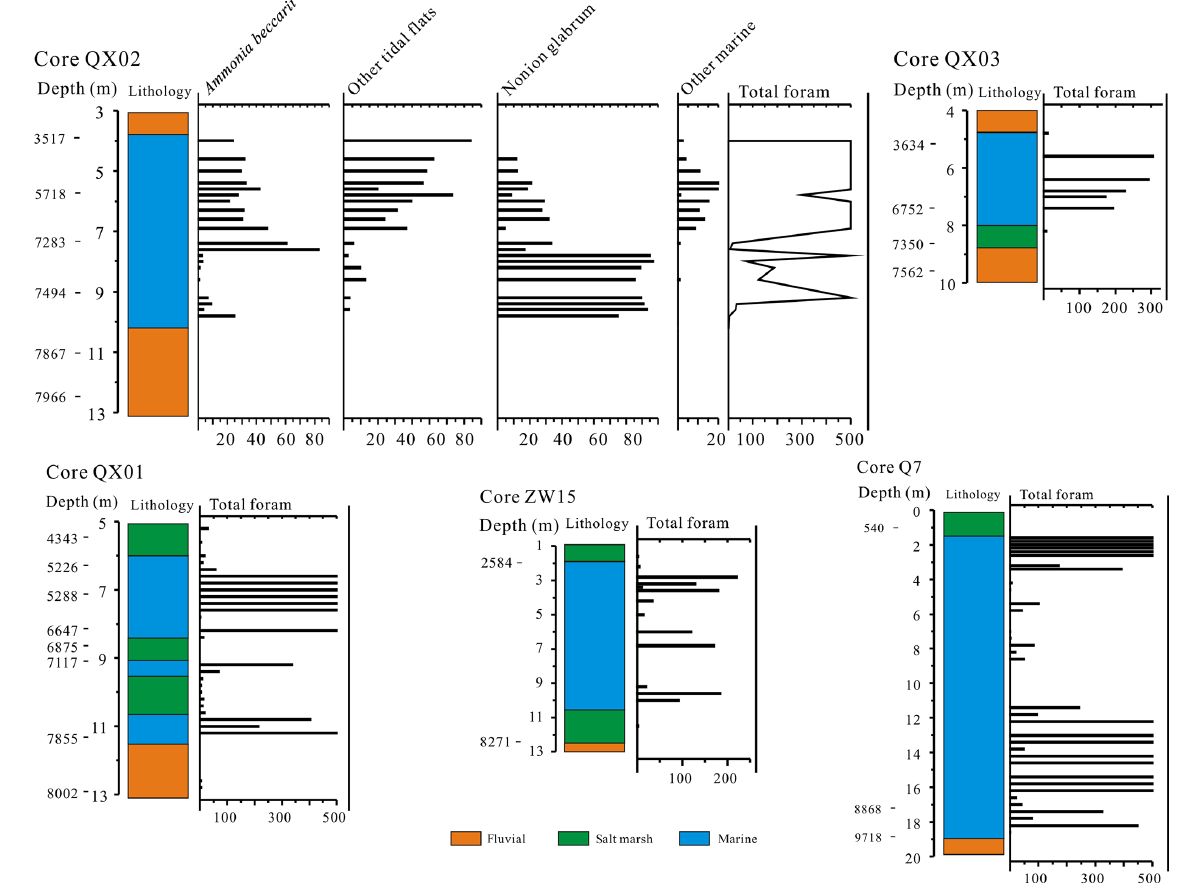
Figure 4. Foraminiferal counts from five cores of transect A. Counts > 500 are shown as 500.